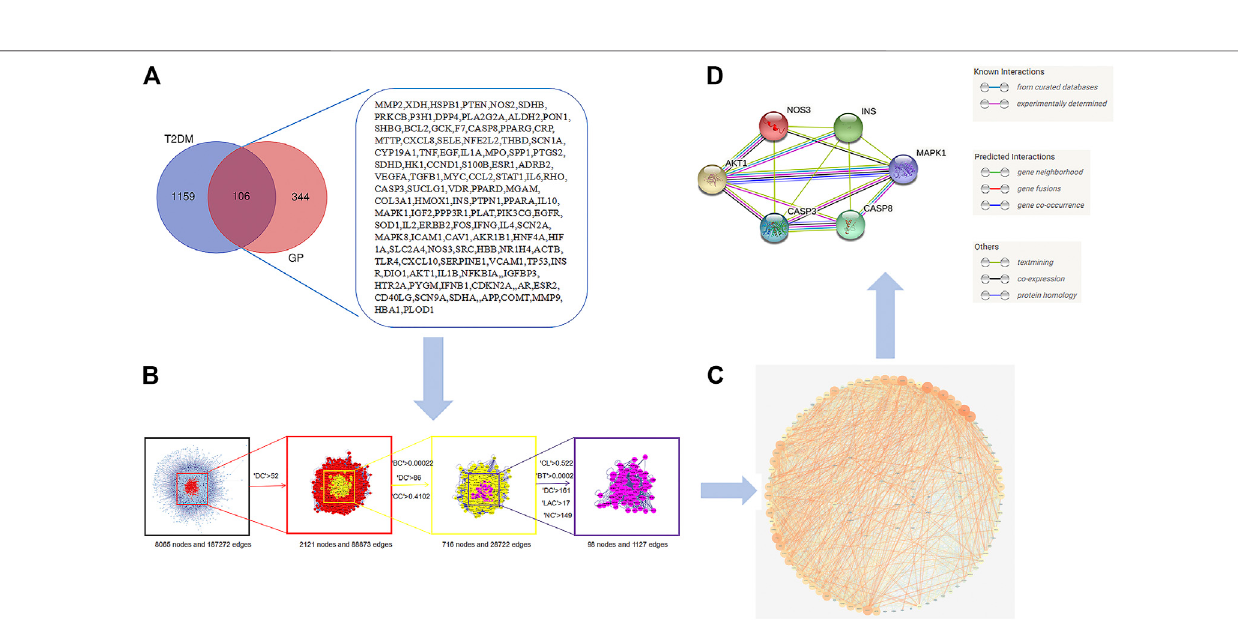
Frontiers in Pharmacology |